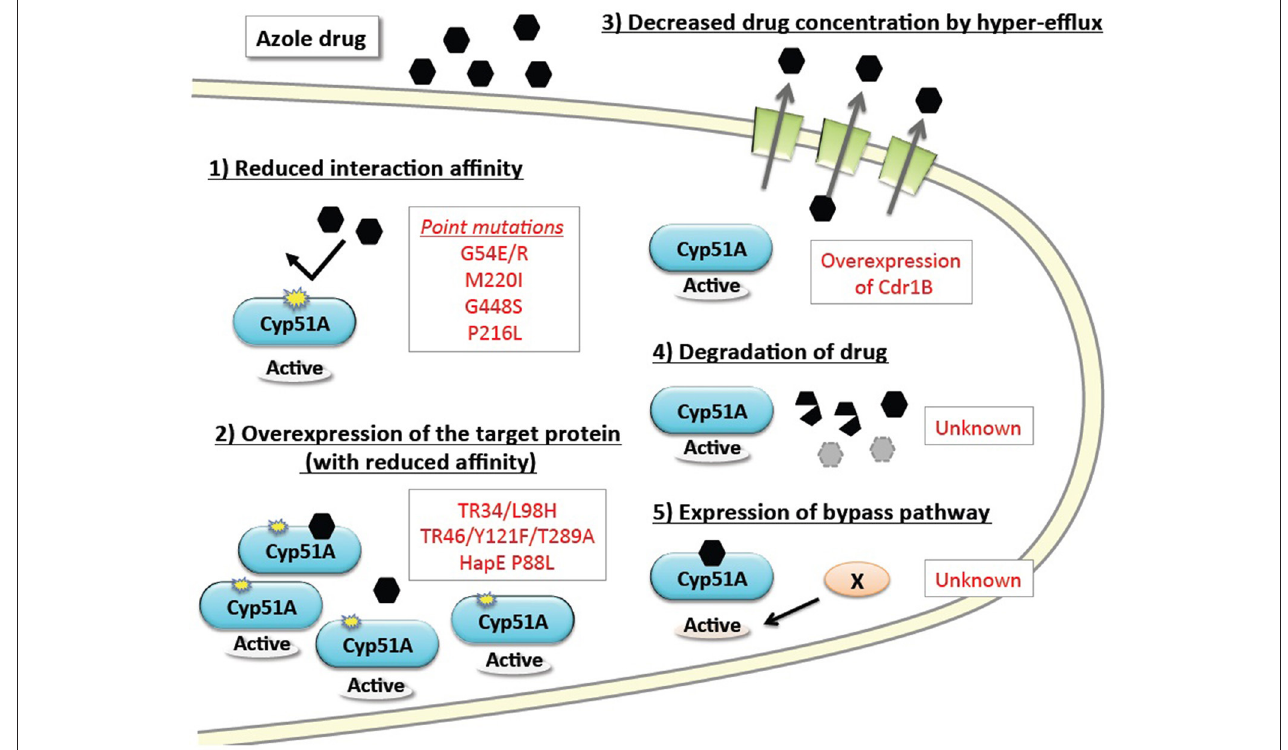
FIGURE 1 | Basic drug resistance mechanisms and the corresponding azole resistance mechanisms in A. fumigatus . Drug resistance mechanisms are categorized into five basic types. The underlying molecular mechanisms identified in A. fumigatus are shown in red text.